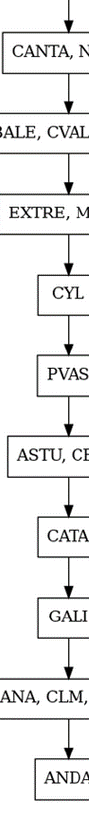
Figure 6. The final ranking aggregating the nine dimensions with ELECTRE III with all weights equal to 1. Table 7. Comparison between our result (ELECTRE III with all weights equal to 1) and INE result (arithmetic